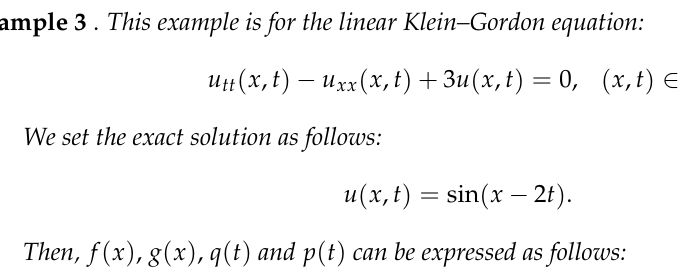
𝑡𝑡 𝑓𝑓 = 1. 𝑡𝑡 𝑓𝑓 = 1. 𝑡𝑡 𝑓𝑓 = 1.